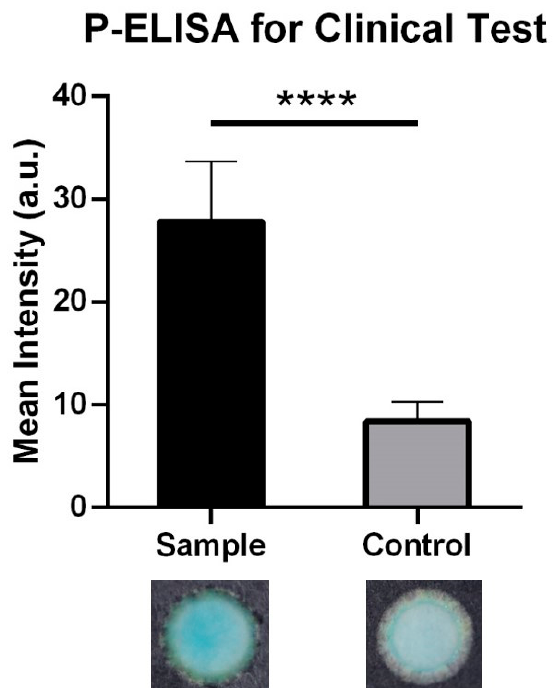
Figure 5. Clinical examination of angiogenin concentration by paper-based ELISA. Test paper was designed to absorb blister fluid from burn patients. Angiogenin signals were captured and analyzed. The mean intensity of detected angiogenin in burn blister fluid was significantly higher than that in normal serum control (mean ± S.D.; **** p < 0.0001, n = 6).